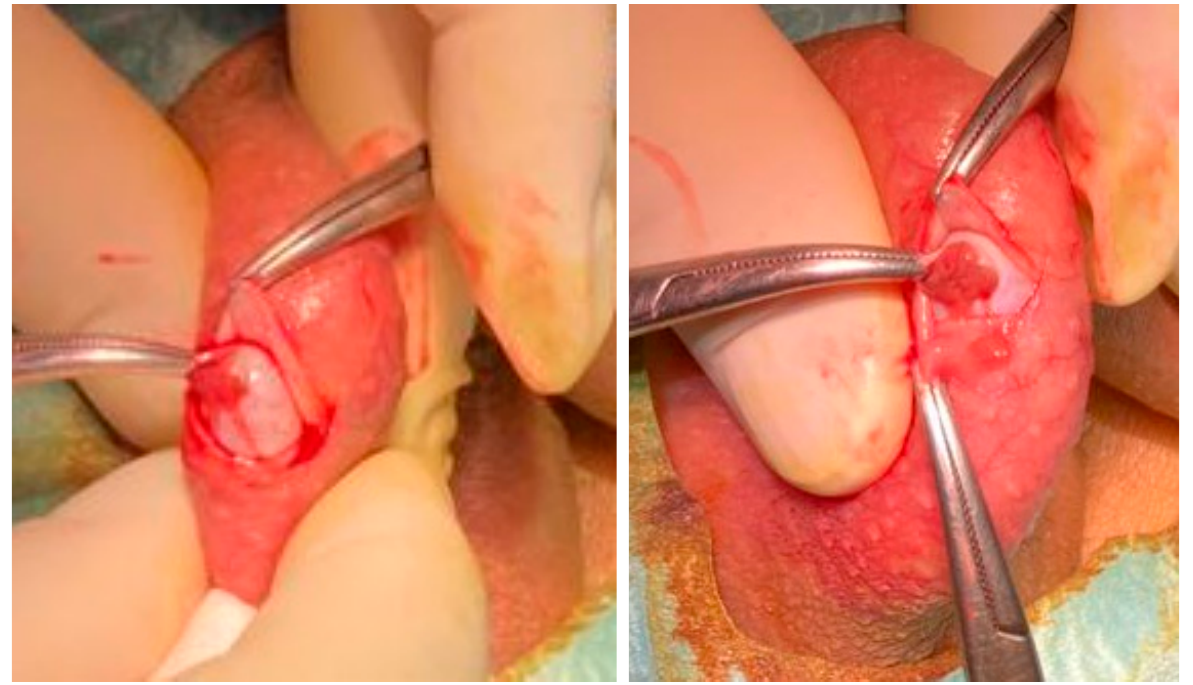
Figure 1. Outpatient conventional TESE employing local anesthesia using the three-finger technique and spermatic cord block. Left . Exposure of the tunica albuginea after entering the tunica vaginalis space. Right . Exposure of the seminiferous tubules.